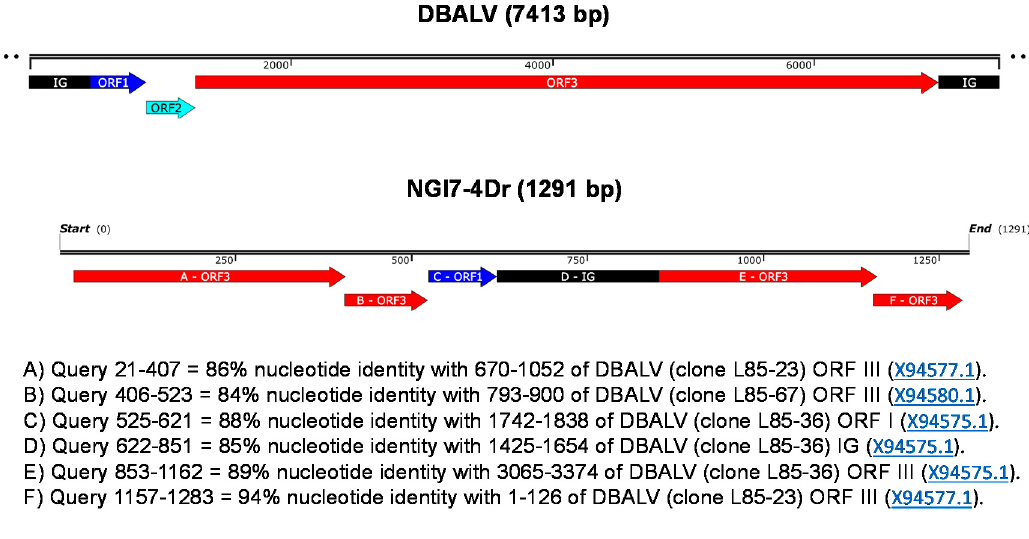
Figure 3. Schematic representation of the rearranged ORF3 of badnavirus clone NGl7-4Dr (KX008602) amplified from D. rotundata TDr 1950B by RCA. The clone length is shown in the linear scale bar and the rearranged fragments are represented in panels A-F. A non-scaled linear view of the genome organization of DBALV is shown in the top panel. The intergenic region (IG) and open reading frames (ORFs) appear with the following colour codes (adapted from Umber et al. [30]): IG, black; ORF1, dark blue; ORF2, light blue; ORF3, red.